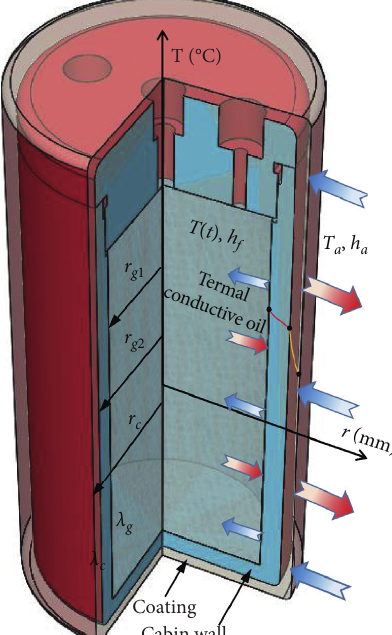
Figure 17: Simplified model of the small test